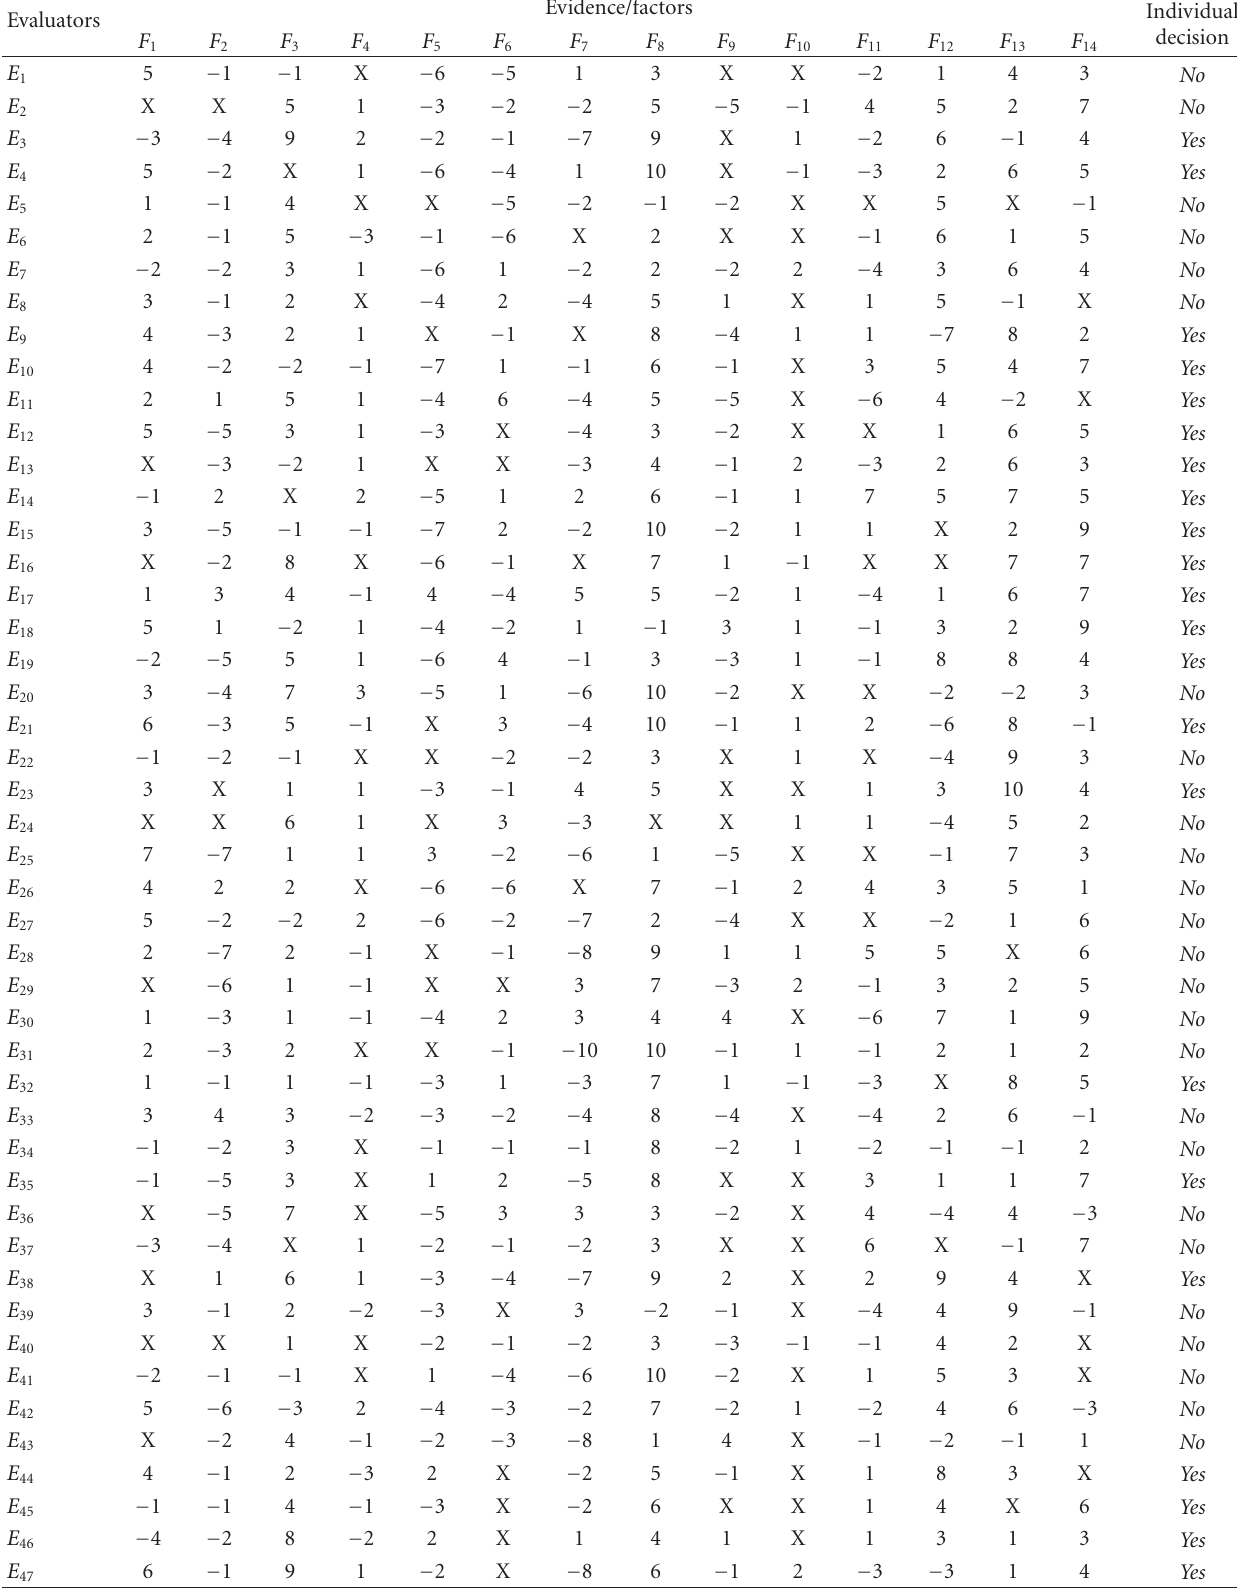
Table 3: Evaluation of factors (evidences) and pre-processing (excluded mean, excluded variance, and variance influence function) of each factor (evidence), and individual decisions. (number of factor (evidence), m = 14; number of evaluators, n =